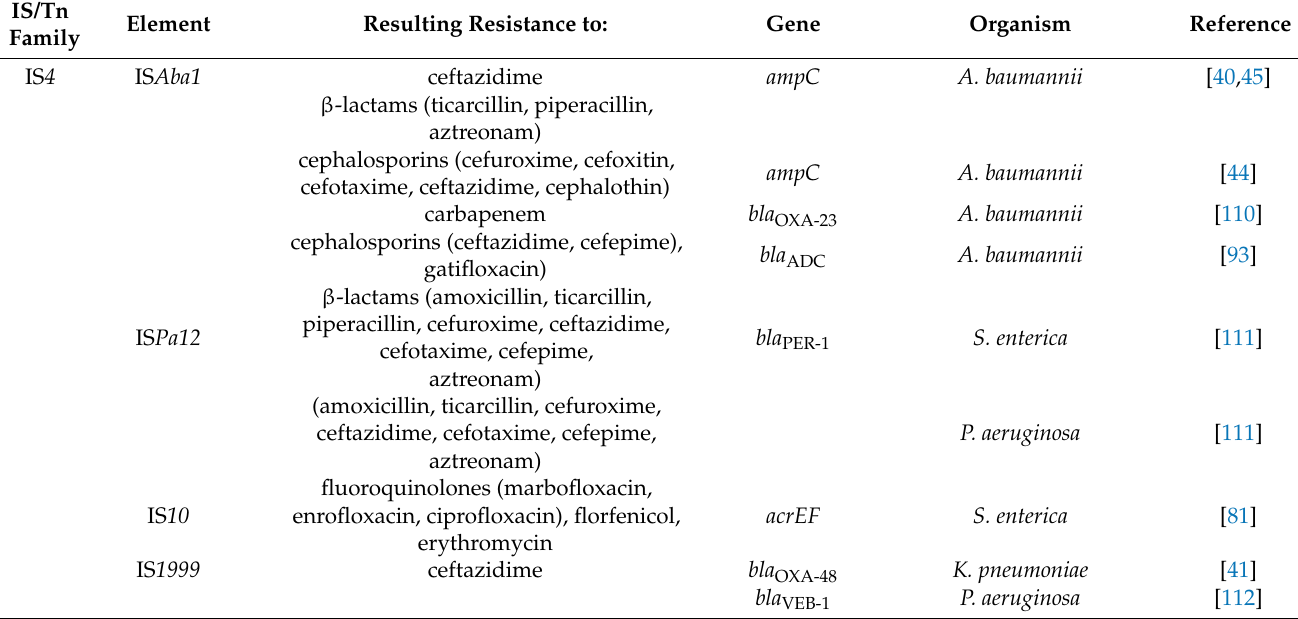
Table 2. AR gene activation caused by TE-borne complete outward-oriented